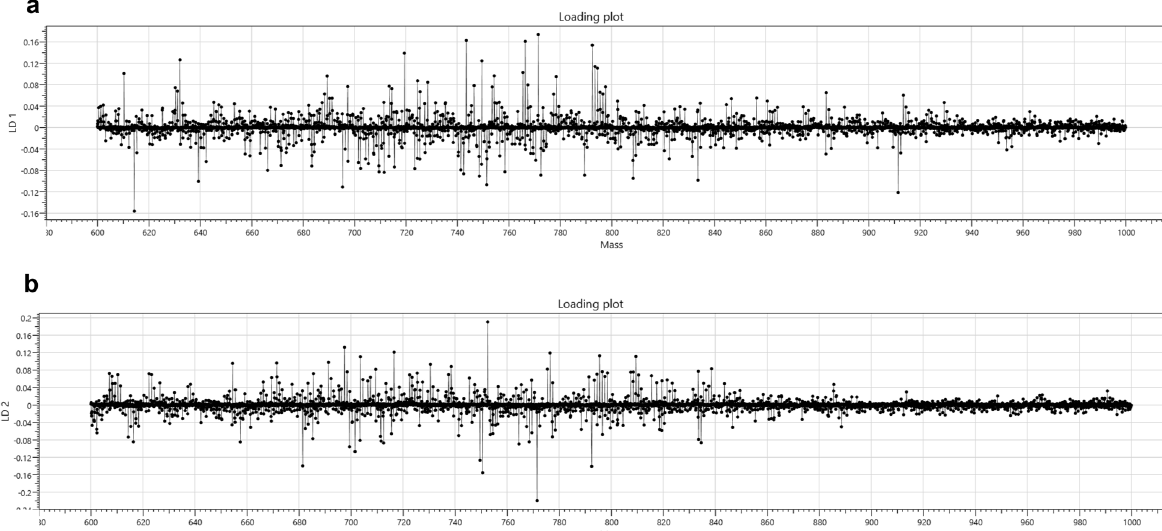
Fig. 4 Meat cut loading plots. a Loading plot showing discreet differences in lipids for Linear Discriminant 1 in the meat cut model. b Loading plot showing discreet differences in lipids for Linear Discriminant 2 in the meat cut